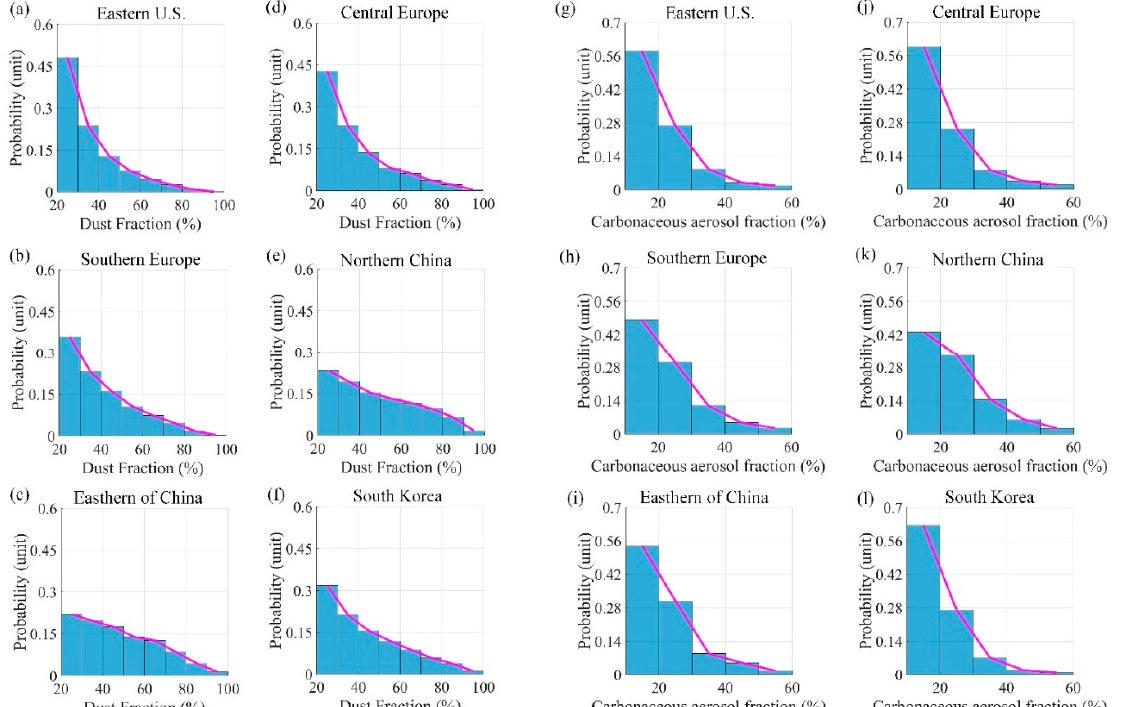
Figure 6. The probability distribution of dust and carbonaceous aerosol fractions in six regions (eastern U.S., central Europe, southern Europe, northern China, eastern China, and South Korea). ( a – f ) represent the probability distribution of the dust fraction in the six respective regions; ( g – l ) represent the probability distribution of the carbonaceous aerosol fraction in the six respective regions, where the horizontal coordinate (10–20% of the scale) actually includes only 15–20% of the fraction. Based on the four types of absorbing aerosol fractions mentioned above, the distri- bution of the lidar ratio relative error with distance was studied using data from different